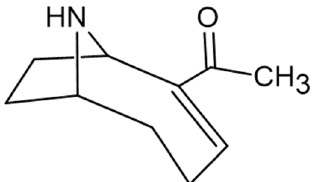
Figure 4. Anatoxin-a(s). The mechanism of action of anatoxin-a(s) is based on the inhibition of the activity of acetylcholinesterase, and in terms of its structure, it can be classified as organophosphate [112]. Homoanatoxin-a (Figure 5), unlike anatoxin-a(s), is structurally similar to anatoxin- a [113]. Figure 5. Homoanatoxin-a. This compound increases the acetylcholine release, the consequence of which is a neuromuscular depolarizing blockade of nicotinic cholinergic receptors in the muscles of mammals [114]. This toxin led to the death of five dogs in New Zealand in 2005. This was due to the presence of cyanobacteria blooms in the Hutt River, which the dogs had contacted [115]. Blocking voltage-gated sodium channels in neurons is how saxitoxin (Figure 6) works [116]. This toxin is structurally a trialkyl tetrahydropurine [117].